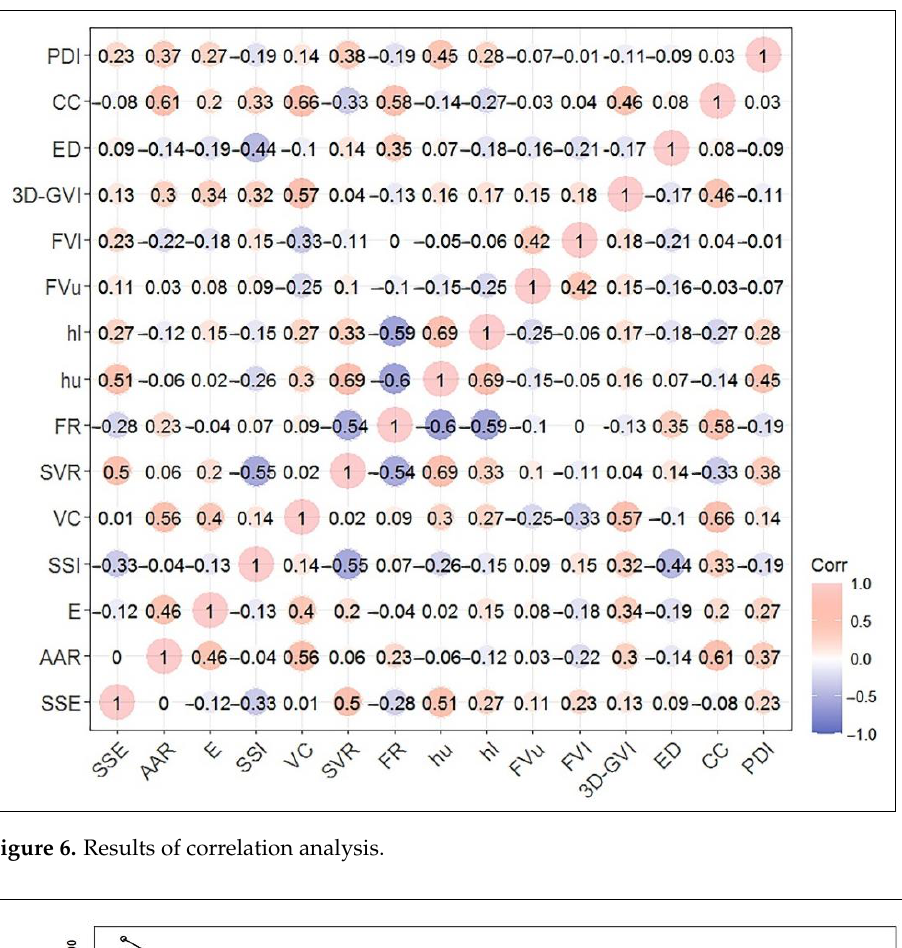
Figure 6. Results of correlation analysis.